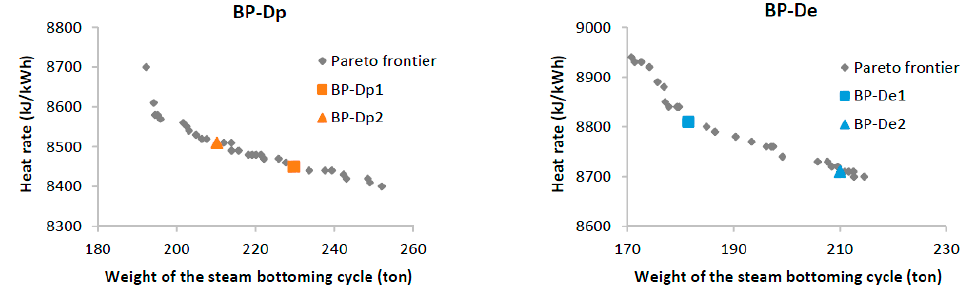
Figure A4. Pareto frontiers of backpressure steam turbine cycle for case D at peak (BP-Dp) and end-life (BP-De) conditions.